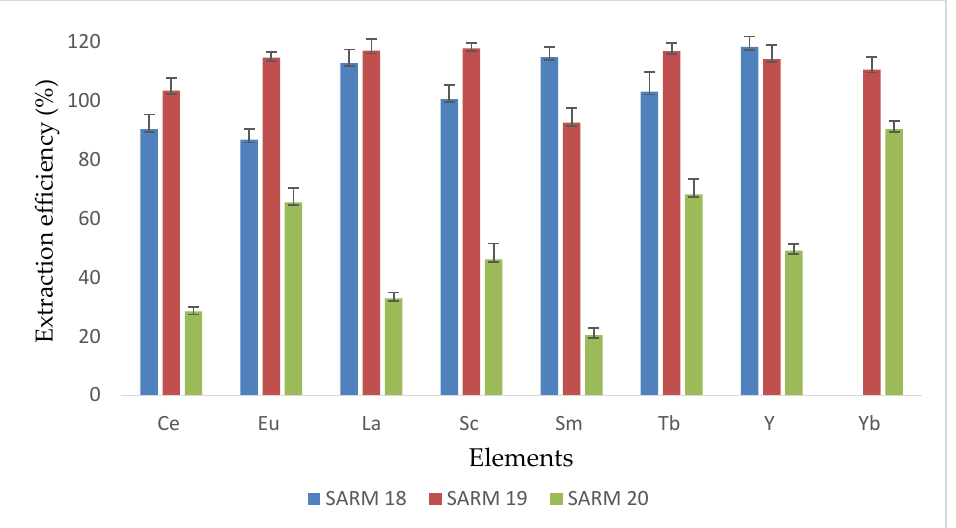
Figure 6. ICP-OES analytical results of REEs in SARM 18, 19, and 20 after MAA-UAE with a dilute HNO 3 solution: UAE conditions: [HNO 3 ] (1 mol L −1 ), sample mass (0.1 g), extraction time (20 min), UAE temperature (80 °C), UAE frequency (high), and replicates ( n = 3).